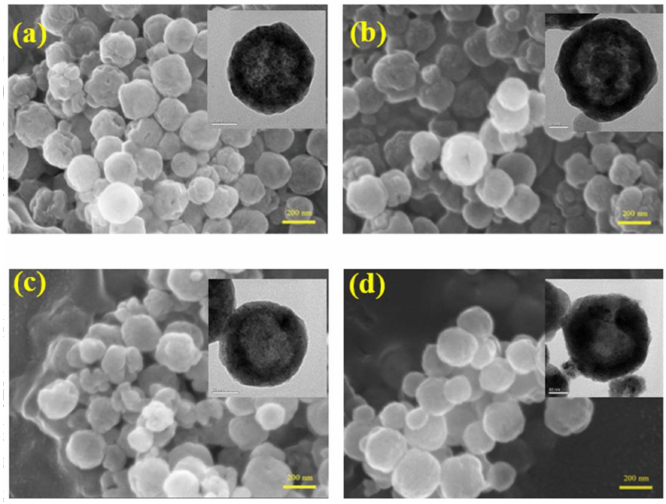
Figure 3. Scanning electron microscope (SEM) and transmission electron microscope (TEM) (inset) photos of S5 ( a ); S20 ( b ); S40 ( c ) and S60 ( d